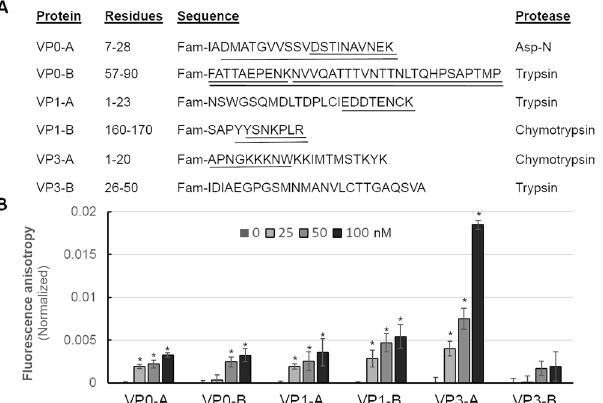
Figure 4. Intrinsically disordered regions in VP0, VP1 and VP3 can interact with HPeV1 RNA. ( A ) RCAP results of peptides from VP0, VP1, and VP3 that could interact with the HPeV1 RNA. The residues in the peptides crosslinked to RNA are underlined. The VP0-A, VP1-A and VP3-A peptides were all missing from the X-ray structure and predicted to be intrinsically disordered. The VP0-B, VP1-B and VP3-B peptides were all modelled in the X-ray structure. ( B ) Peptides from intrinsically disordered regions of VP0, VP1, and VP3 can bind to HPeV1 RNA in a fluorescence anisotropy assay. Each error bar shows one standard deviation of three independent measurements. The asterisk denotes the samples whose anisotropy values differ from the anisotropy value of the peptide alone by a p value of < 0.02 in the Student’s